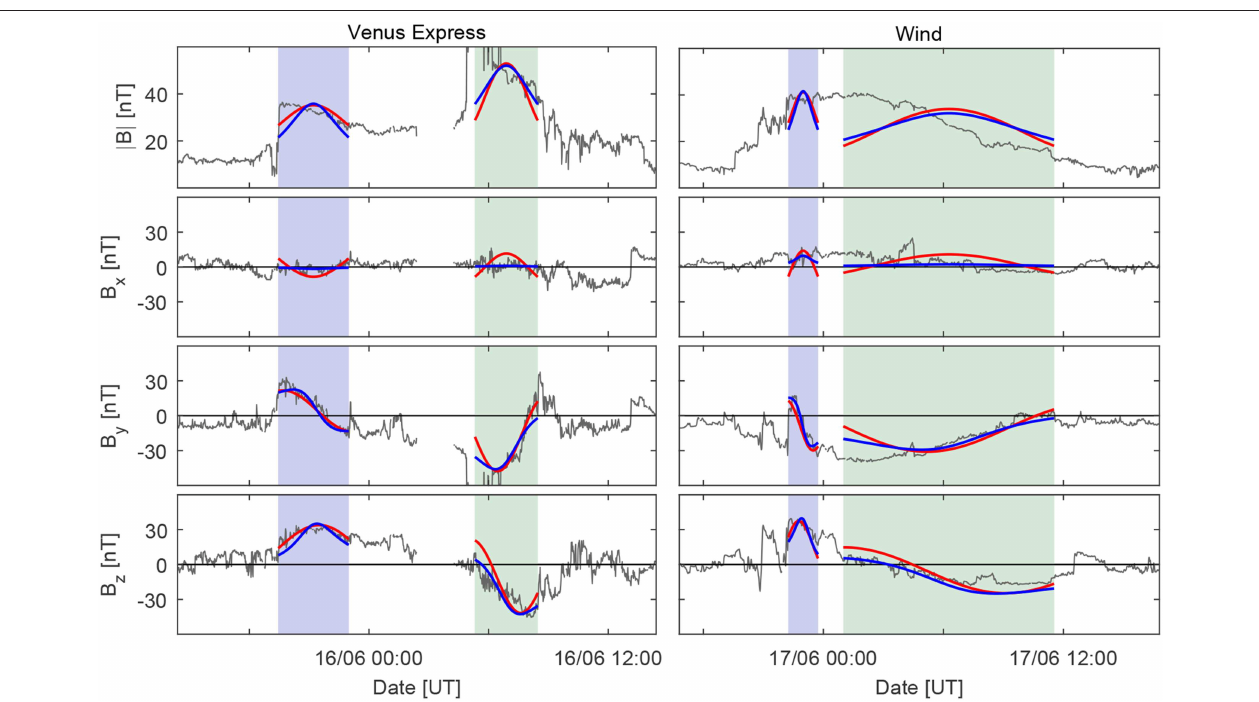
FIGURE 8 | Gold-Hoyle fits (blue lines) and Lundquist fits (red lines) to the magnetic field data at VEX (Left) and Wind (Right) separately for FR2 (blue-shaded interval) and FR3 (green-shaded interval). Measurements made in the Venusian magnetosphere have been removed. The panels show, from top to bottom, the magnetic field magnitude and the three field components in Spacecraft Equatorial (SCEQ) coordinates. The SCEQ coordinate system is identical to the Heliocentric Earth Equatorial (HEEQ; Thompson, 2006) system at the locations of Earth and the Sun–Earth L1